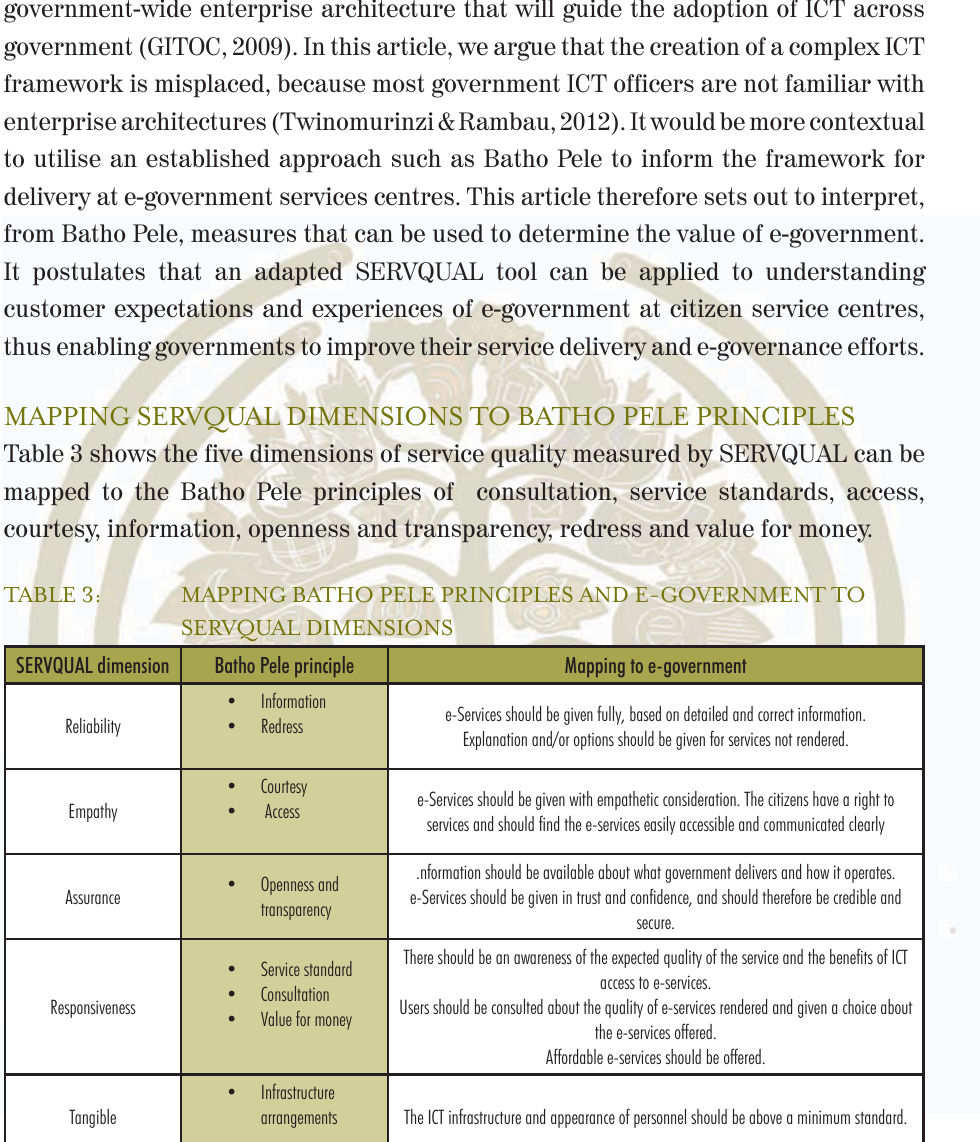
MAPPING BATHO PELE PRINCIPLES AND E-GOVERNMENT